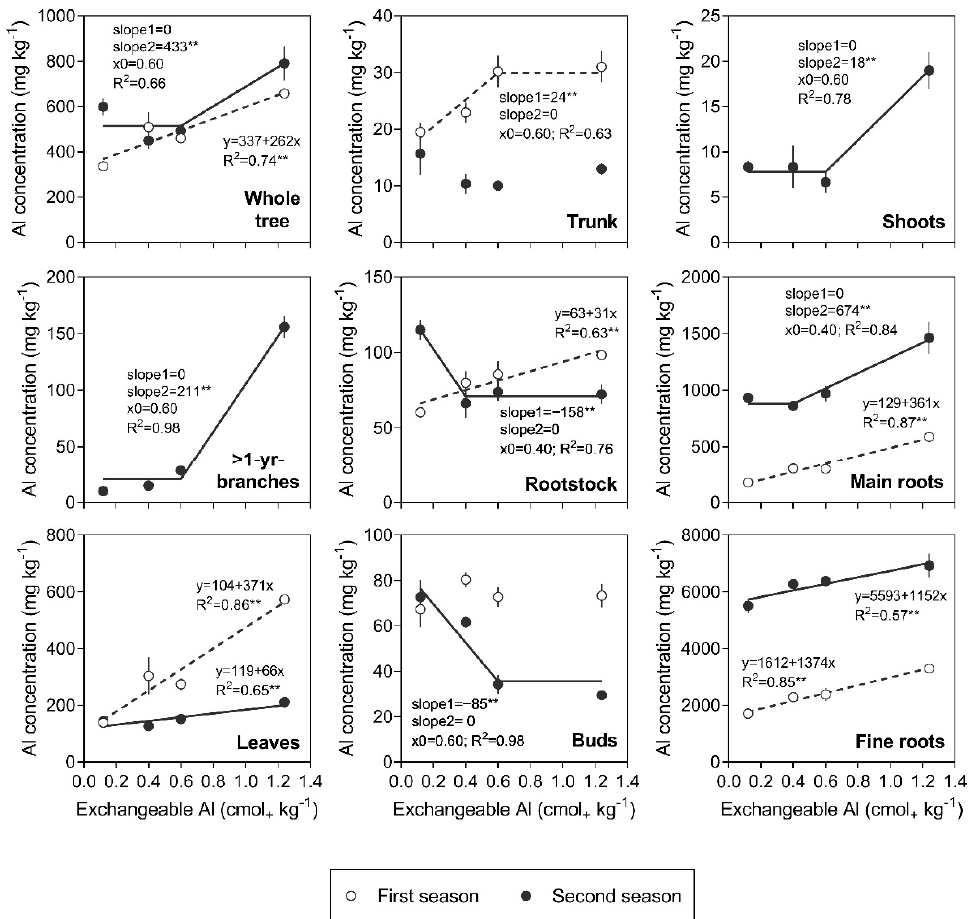
Figure 4. Relationship between Al concentration (in dry weight) in the whole tree and in individual organs of sweet cherry trees and exchangeable Al in a volcanic soil. Values are the means, with standard errors as vertical bars ( n = 3). Significance of slopes: ** p < 0.01. In segmental regression, slope1 is the slope of the first line segment, slope2 is the slope of the second line segment, and X0 is the X value where the two line segments intersect.